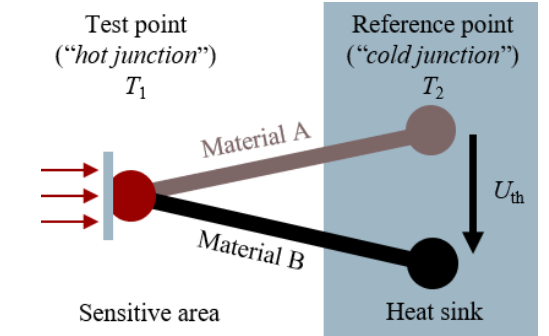
Figure 4. Principle of a thermopile